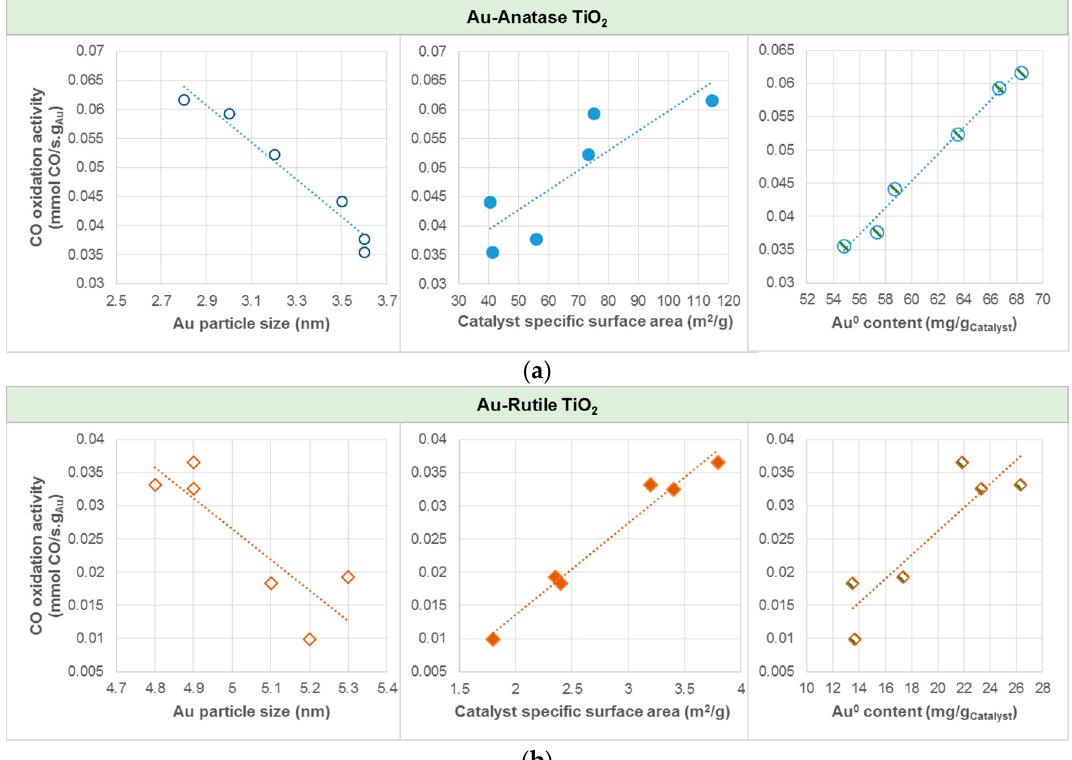
Figure 7. Effects of Au particle size, catalyst specific surface area, and Au 0 content on CO oxidation activity for ( a ) Au-Anatase TiO 2 , and ( b ) Au-Rutile TiO 2 . Note: Au 0 content in mg/g Catalyst was calculated by the total amount of catalyst multiplied by the gold loading and the Au 0 atomic percentage.